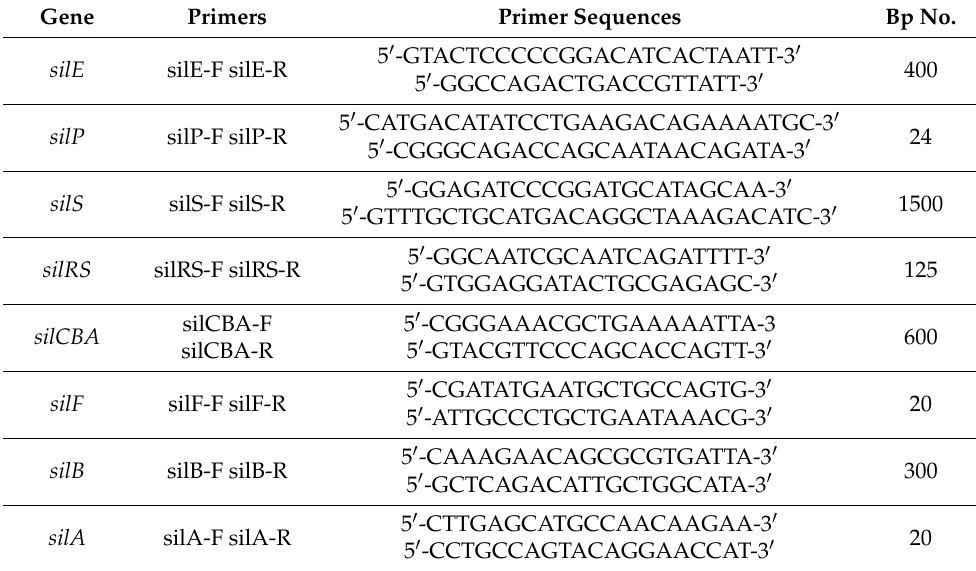
Table 1. Sequences of primers used and their